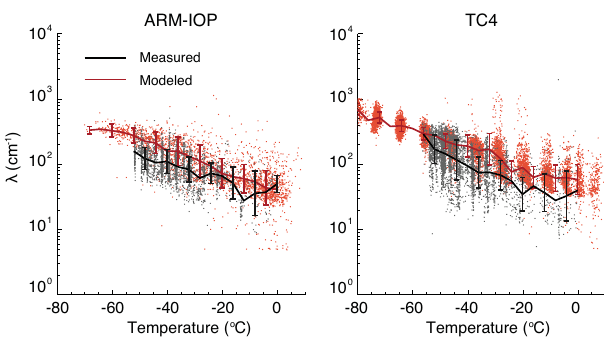
Figure 2. Slope parameter, modeled (red) and measured (black) for ARM-IOP and TC4. The lines are the geometric mean, the dots rep- resents a fraction of the measurements and modeled values, while the vertical bars represents the geometric standard